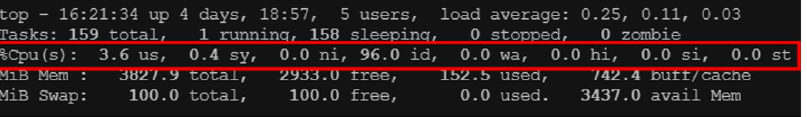
Figure 8. The system information of SCADA server in status of accessing sensor with TEVM mechanism.